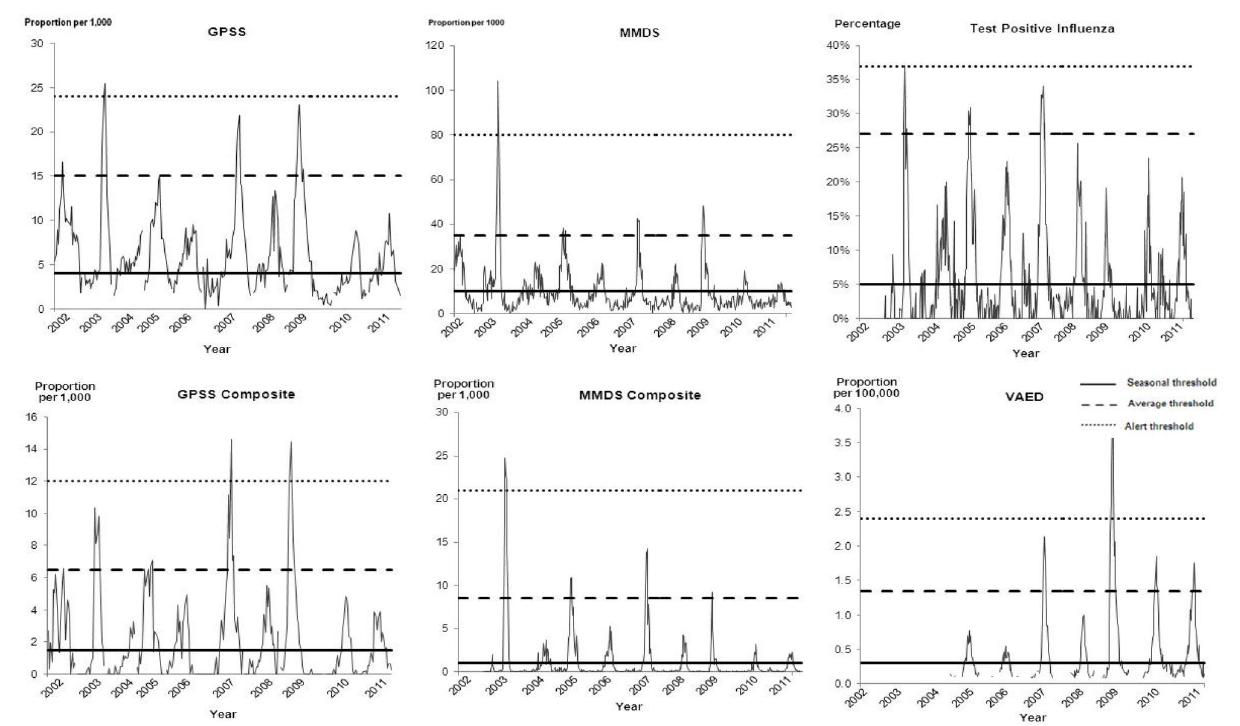
Figure 4. Categories of influenza season in Victoria for six surveillance datasets, 2002-2011.